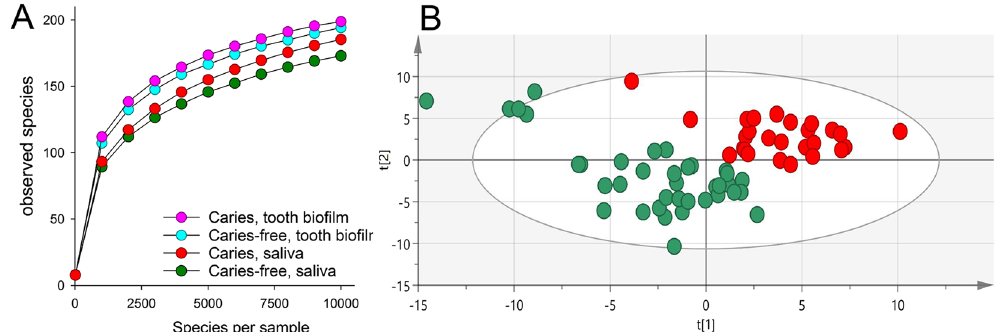
Figure 3. Species richness in saliva and tooth biofilm samples from 17-year old Swedish adolescents and subject clustering. ( A ) Rarefaction curves showing species richness based on number of species by species per sample in saliva and tooth biofilm samples. ( B ) Principal component analysis (PCA) scatter plot separating the caries-affected (red dots) from caries-free adolescents (green dots) based on microbial taxa detection in saliva and lifestyle